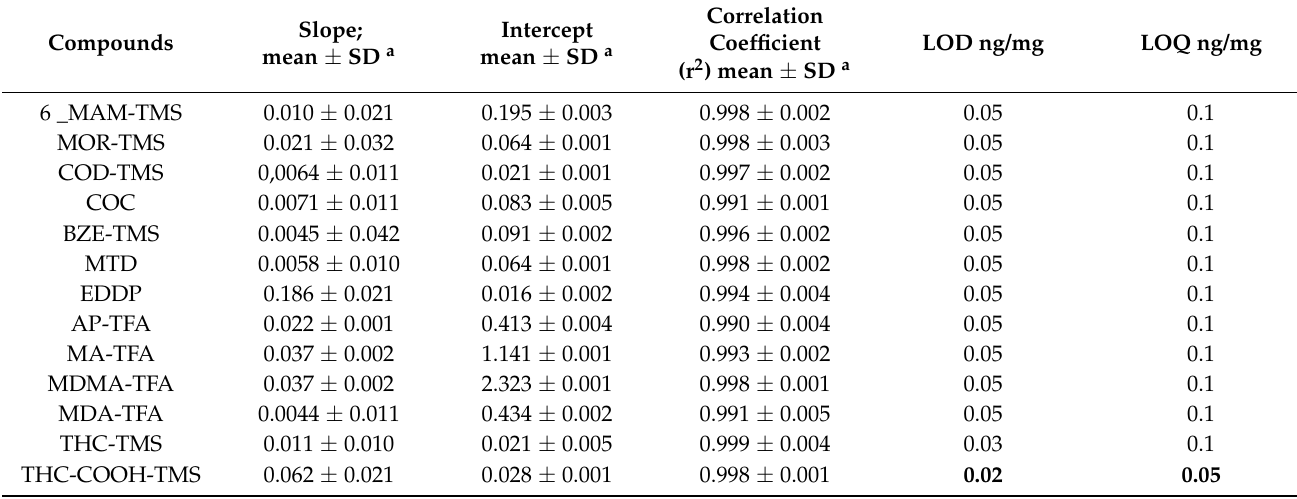
Table 2. Calibration parameters, limits of detection (LOD), and limits of quantification (LOQ) for analytes under investigation.